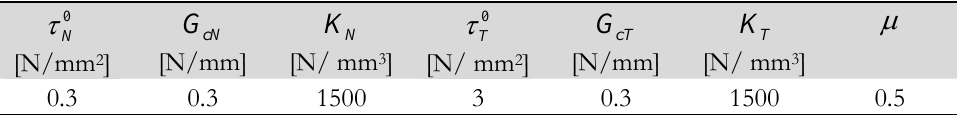
Tabella 4: Parametri di interfaccia del modo I e del modo II.